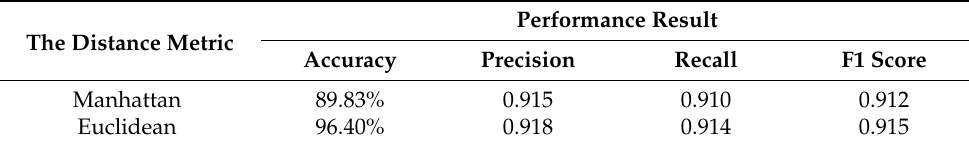
Table 2. Comparing performances by Euclidean and Manhattan distances for k-NN.